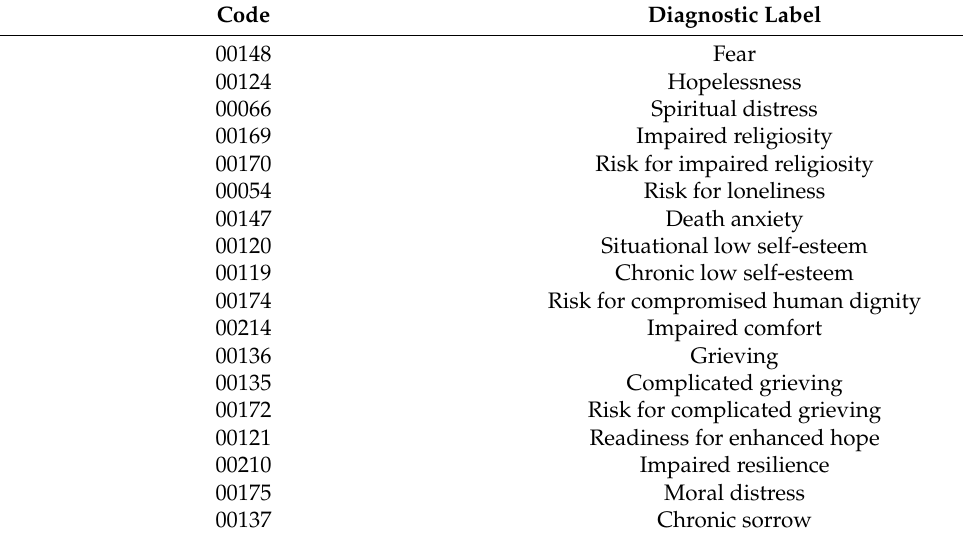
Table 1. NANDA-I Diagnoses for spiritual and emotional